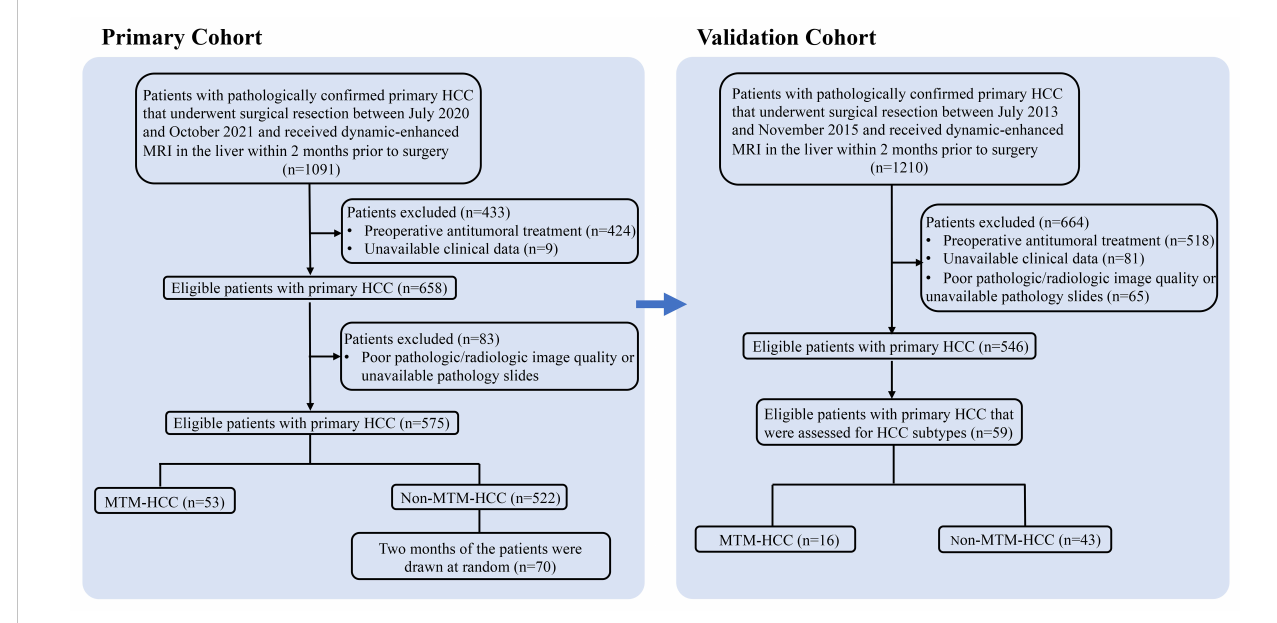
FIGURE 1 Flow chart shows the patient selection procedure. HCC, hepatocellular carcinoma; MTM, macrotrabecular-massive